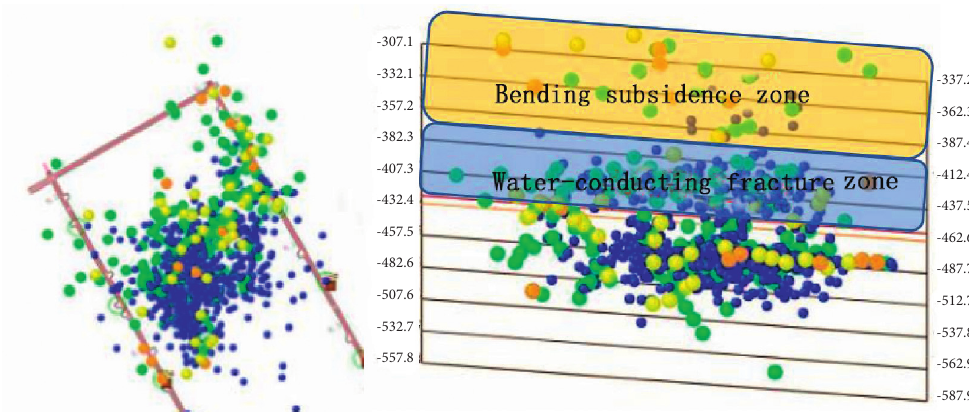
Figure 7: Plan and profile of the 16001 working face microseismic event distribution in the stage before the square stage.